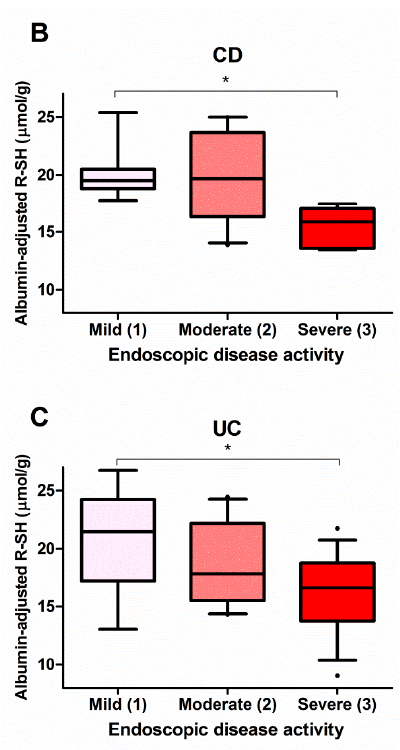
Figure 2. Albumin-adjusted serum free thiols are significantly decreased in ( A ) IBD patients, ( B ) CD patients and ( C ) UC patients with severe endoscopic disease activity as compared to mild disease activity (** P < 0.01; * P < 0.05).